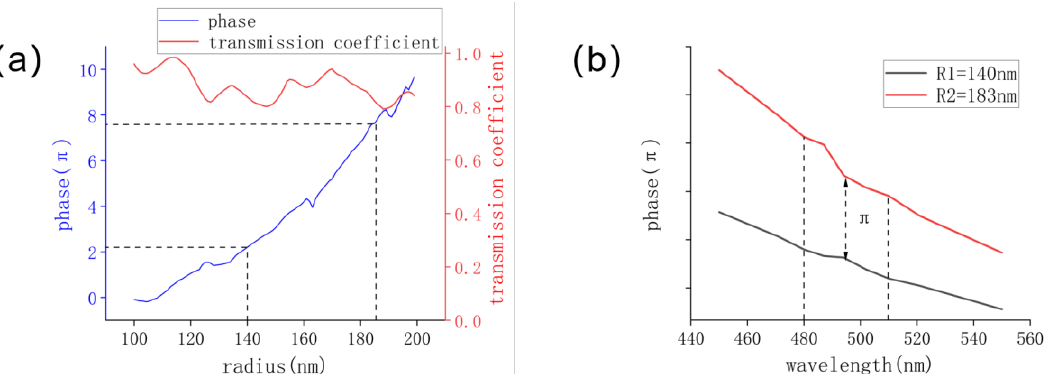
Figure 2. ( a ) Curve of phase change and transmittance of the straight waveguide as the radius R of the waveguide from 100 nm to 200 nm. ( b ) The transmission phase difference of the straight waveguide with two radii of R 1 = 140 nm and R 2 = 183 nm with a plane